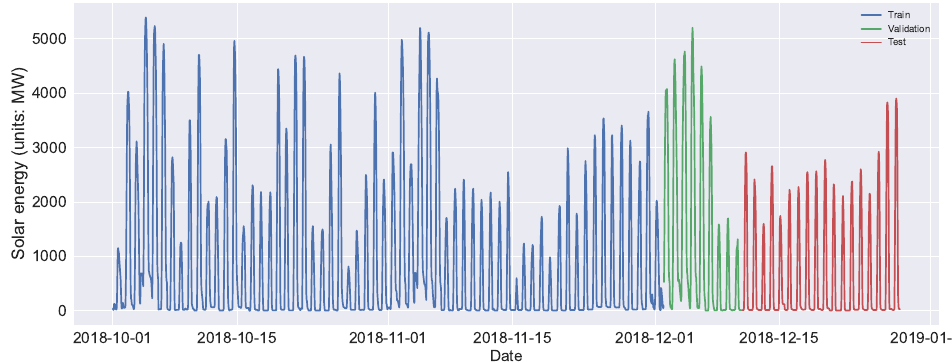
Figure 3. Visualization of the utilized solar energy data